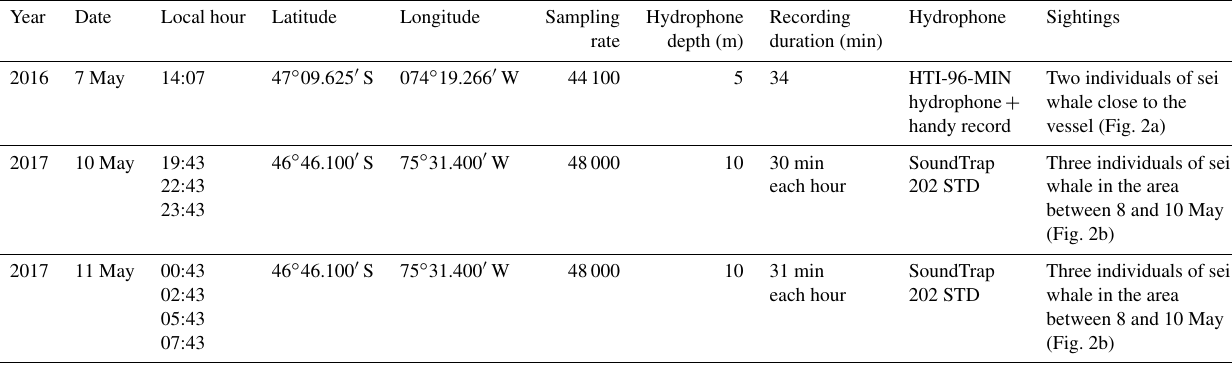
Table 1. Sei whale recordings at Penas and Tres Montes gulfs.